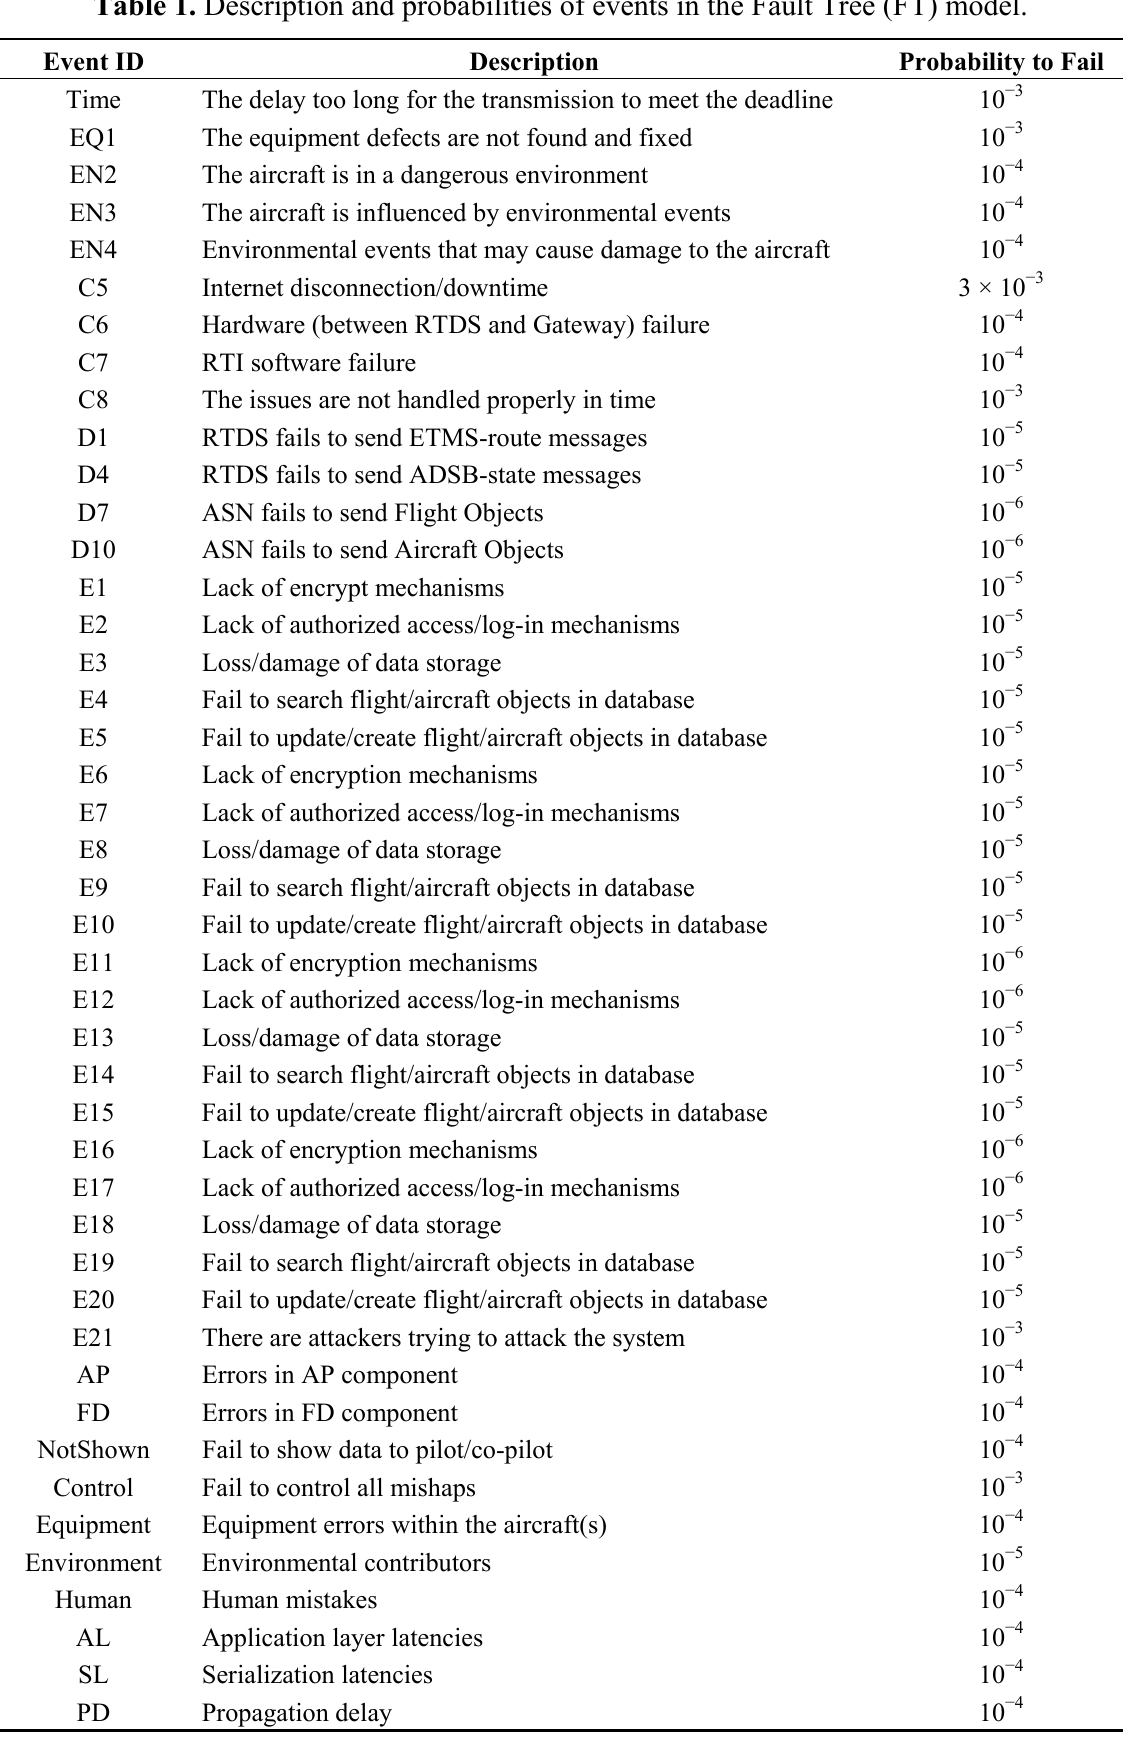
Table 1. Description and probabilities of events in the Fault Tree (FT) model. Event ID Description Probability to